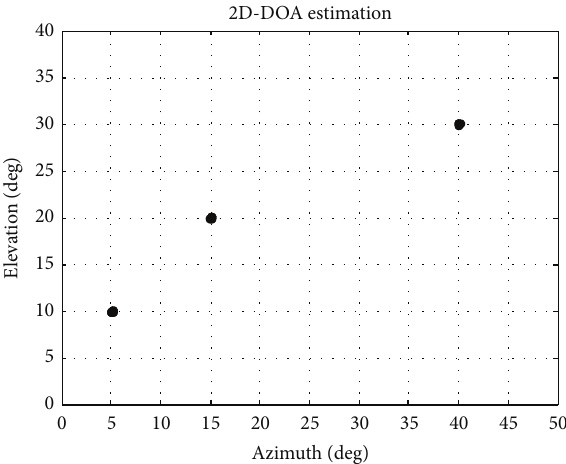
Figure5:2D-DOAestimationofouralgorithminSNR = 5 dB( 𝑁 = 20 , 𝑀 = 16 , 𝐿 = 100 , and 𝐾 = 3 ).